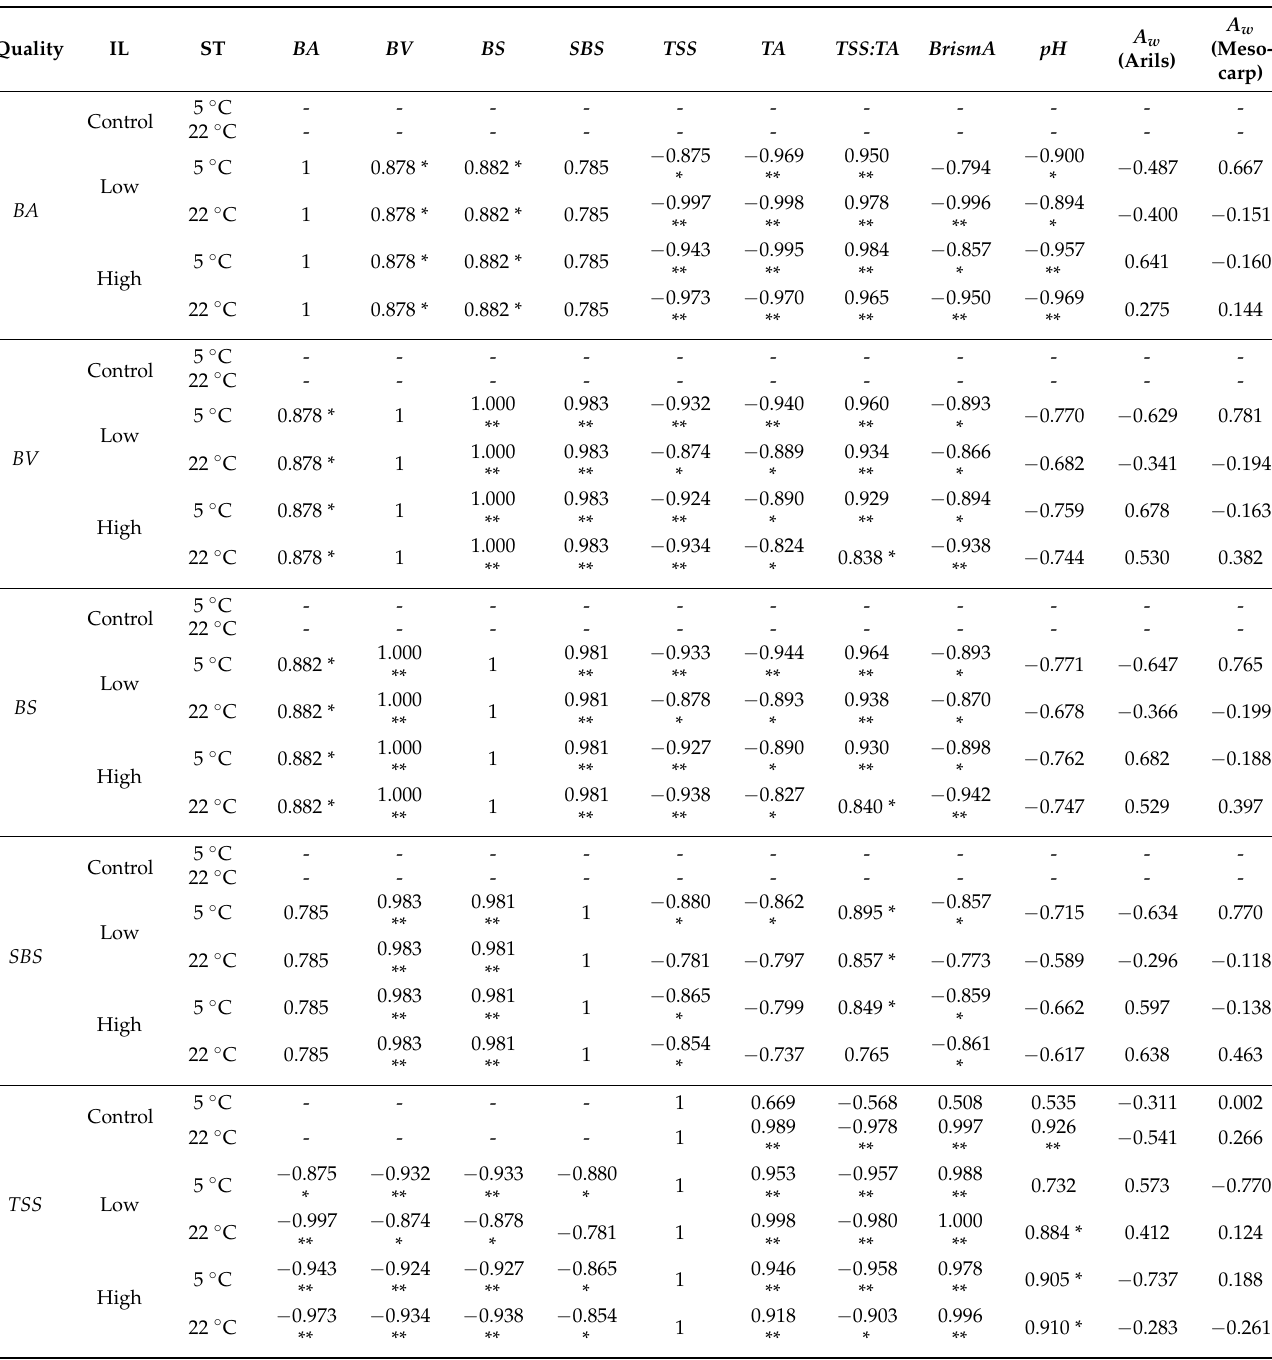
Table 5. Pearson correlation coefficients ( r ) between the BA , bruise volume ( BV ), bruise susceptibility ( BS ), specific bruise sensitivity ( SBS ), total soluble solids ( TSS ), titratable acidity ( TA ), sugar:acid ratio ( TSS:TA ), BrimA , pH , and water activity ( A w ) (arils and mesocarp) of non-bruised, low-impact (45 ◦ ; 1.18 J), and high-impact (65 ◦ ; 2.29 J) bruised pomegranate fruit over 28 days of storage at 5 ◦ C and 22 ◦ C. Significant correlations of two-tailed tests are indicated: *, p < 0.05; **, p < 0.001. IL;